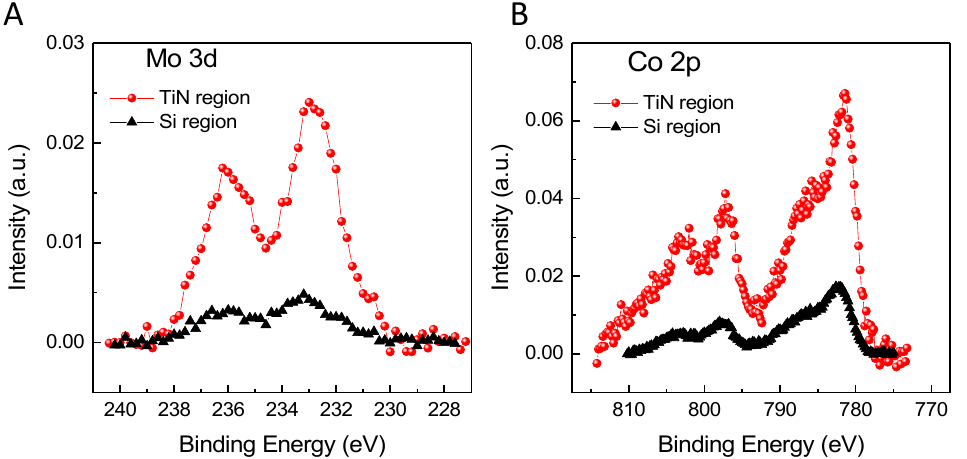
Figure 4. XPS spectra of Mo 3d ( A ) and Co 2p ( B ) on TiN and sputtered-Si regions, after catalyst deposition and subsequent calcinations to 673 K.